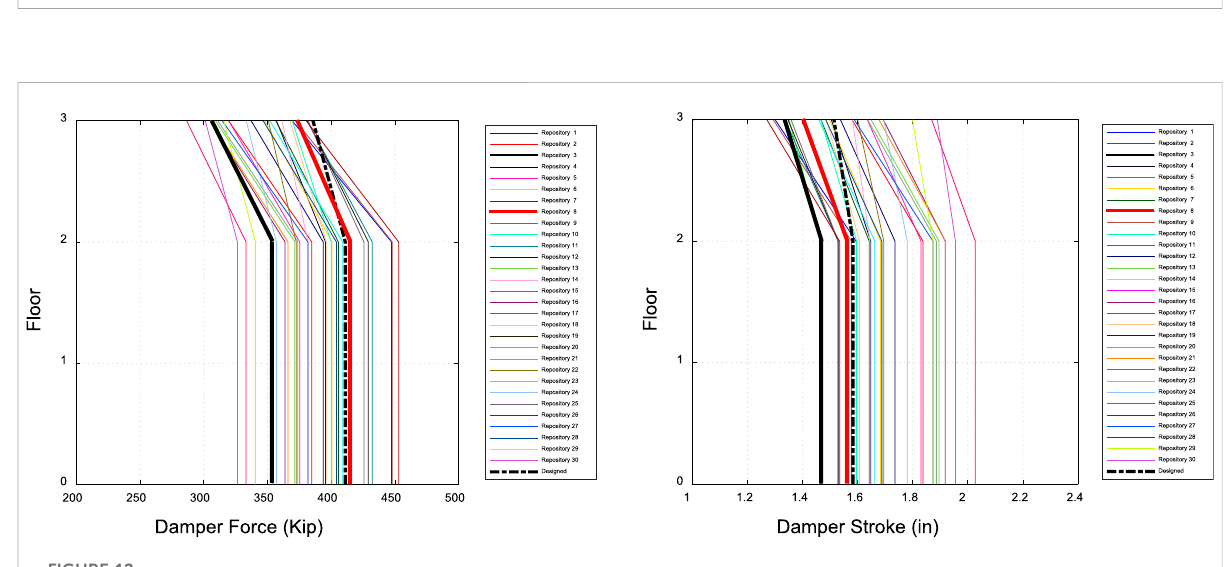
FIGURE 12 Dampers ’ forces and strokes for MOPSO (original VDMF design - black dashed line; repository 3 — thick black line; repository 8 - tick red